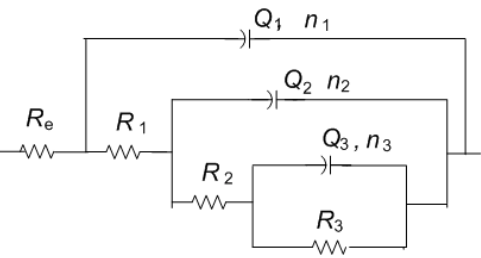
Figure 12. Electrical equivalent circuit used for analysis of EIS data in Figure 9. Table 6. EIS parameters obtained by fitting impedance data in Figure